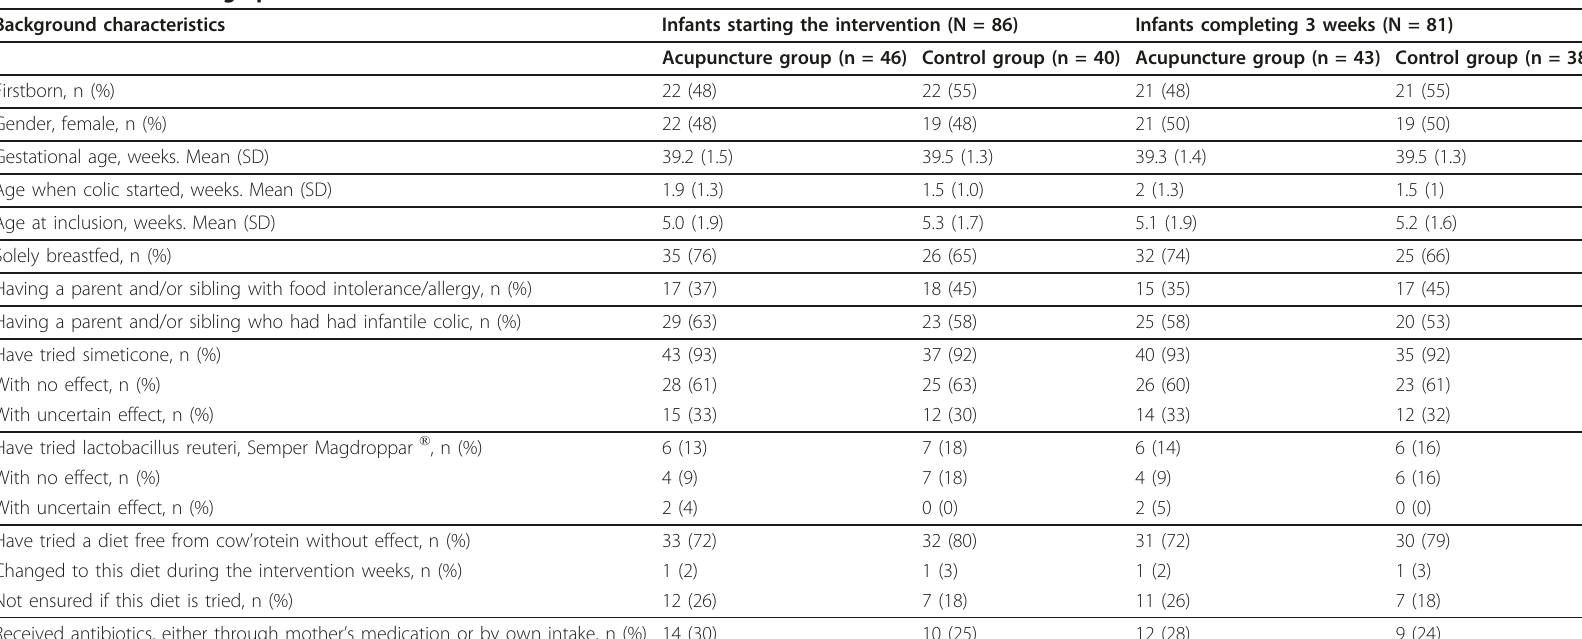
Table 1 Baseline demographic